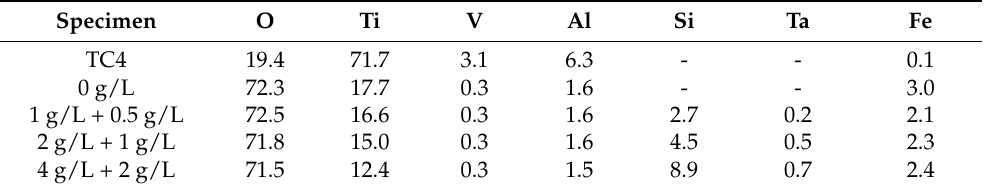
Table 6. Percentage of elements of the wear scar of both the TC4 alloy and the composite MAO coatings with different concentration of Si 3 N 4 /TaC particles (wt.